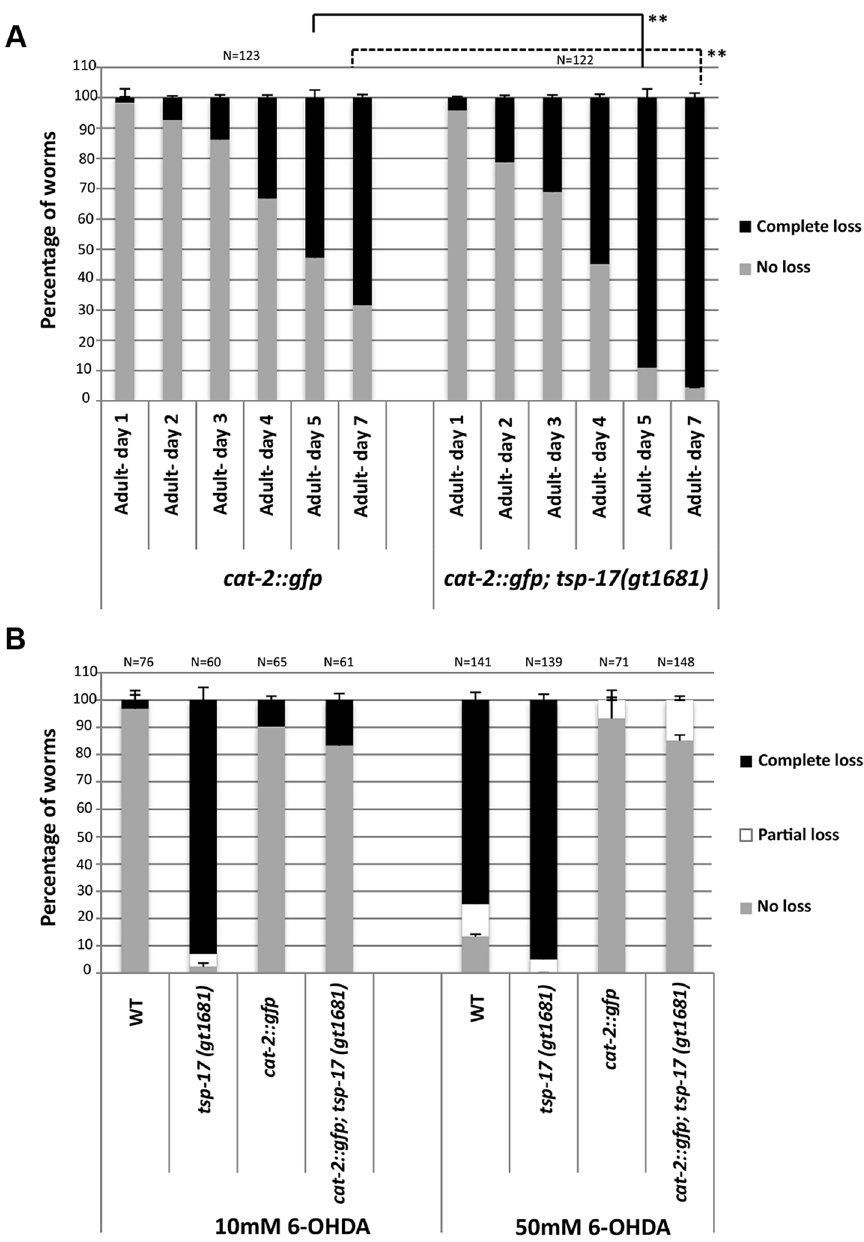
Figure 4. tsp-17 (gt1681) enhances the neurodegeneration phenotype of cat-2 -overexpressing lines, and cat-2 overexpression protects against 6-OHDA toxicity. A . cat-2 induced neurodegeneration. Analysis of cat-2 -overexpressing stains UA57 baIn4 [pdat-1::gfp pdat- 1::cat-2] and TG2402 baIn4[pdat-1::gfp pdat-1::cat-2]; tsp-17(gt1681) . Error bars represent standard deviation. Asterisks represent statistical difference between cat-2::gfp adults on days 5 and 7 (**p , 0.005). B . cat-2 overexpression suppresses 6-OHDA-induced neurotoxicity. Experiments were done in triplicate and the average is shown. Data presented is from scoring the extent of neurodegeneration 72 h post 6-OHDA intoxication.